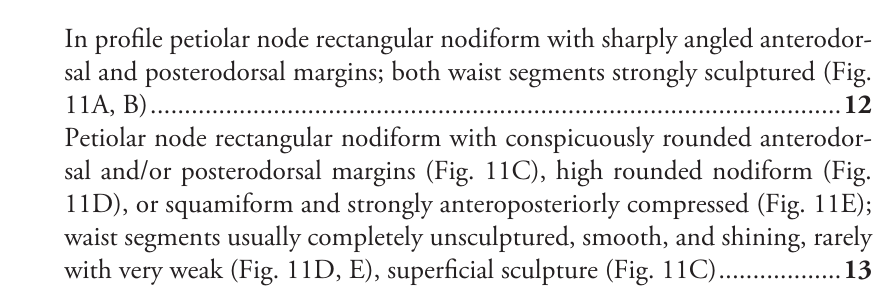
11 In profile petiolar node rectangular nodiform with sharply angled anterodor- sal and posterodorsal margins; both waist segments strongly sculptured (Fig.